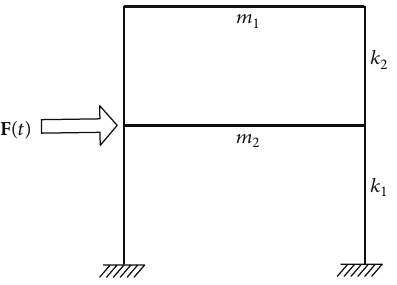
Figure 1: A two-storey shear structure.